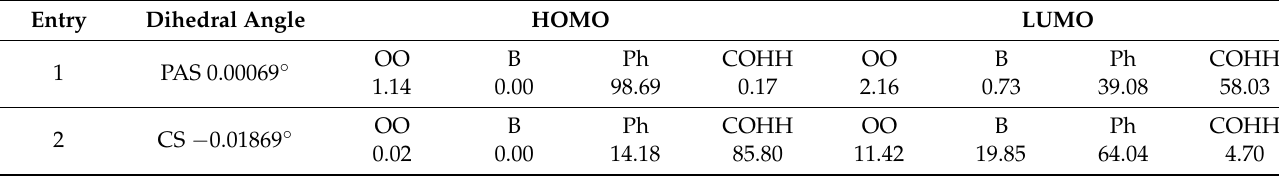
Table 4. Calculated projected density of state values (pDOS, %) for the HOMO/LUMO orbital of PAS and